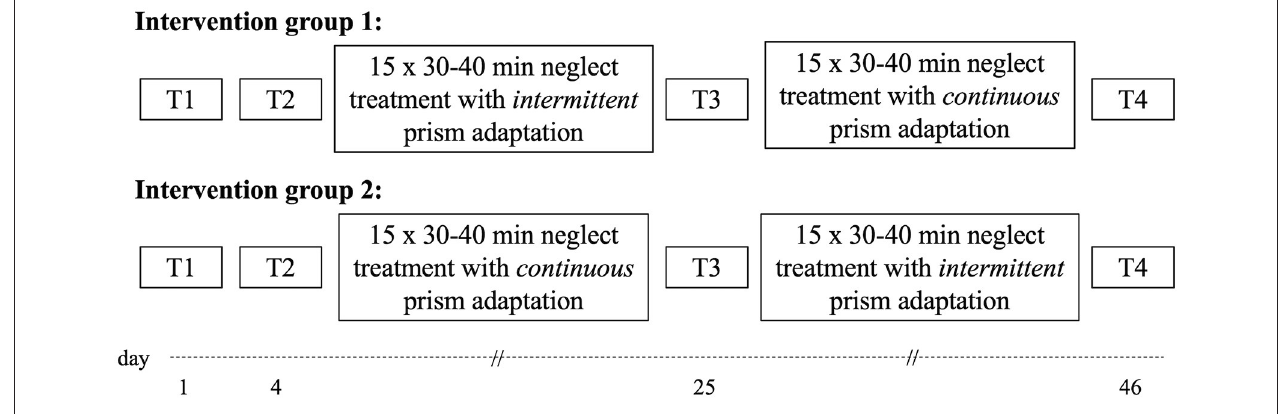
FIGURE 2 | Overview of the study